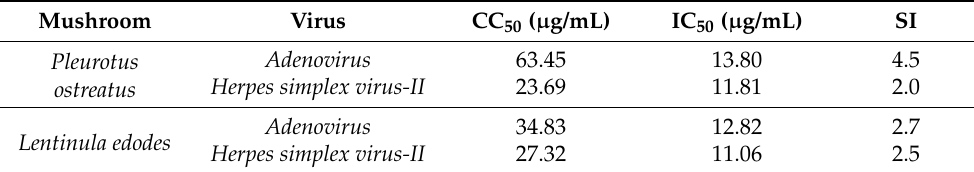
Table 5. Antiviral effect of Pleurotus ostreatus and Lentinula edodes